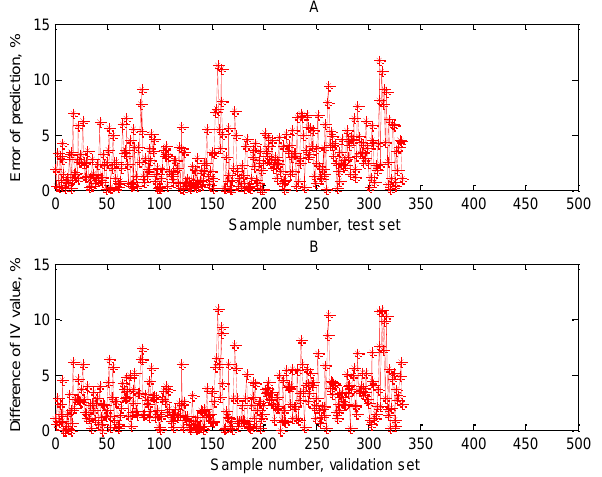
Fig. 8 Error of prediction. A= Raman IVs vs. GC IVs of fresh sample; Maximum = 11.66%, Mean = 2.79%; B=GC IVs of frozen sample vs. GC IVs of fresh sample, Maximum = 10.95%, Mean =